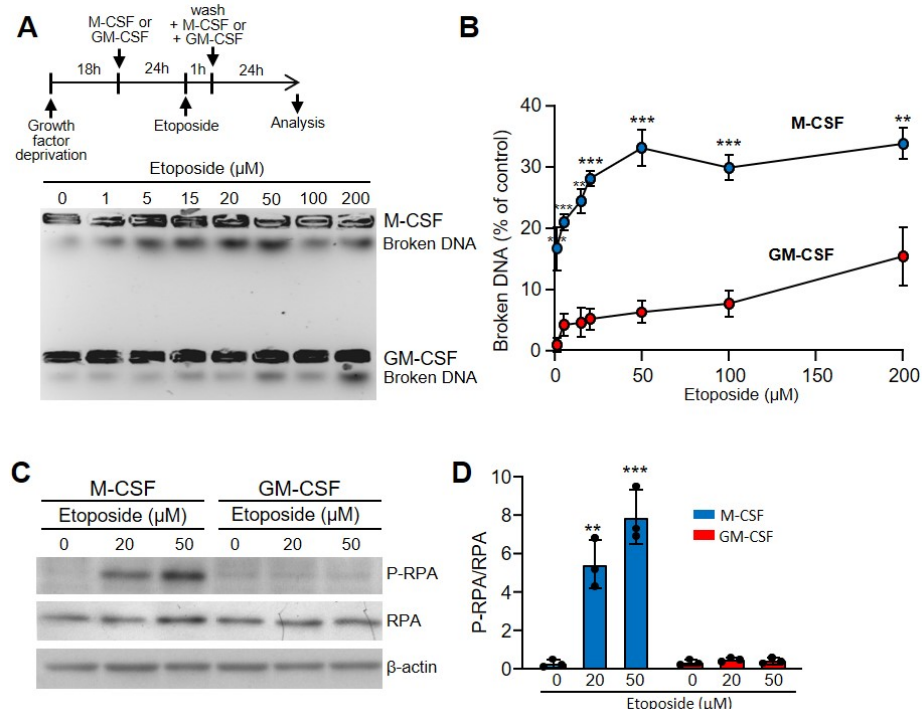
Figure 1. Etoposide induced more DSBs in macrophages incubated with M-CSF in relation to those incubated with GM-CSF. ( A ) The experimental design is shown at the top. Macrophages were obtained after 7 d of culture in the presence of M-CSF. Cells were deprived of M-CSF for 18 h and then incubated for 24 h with M-CSF or GM-CSF. Unless specified otherwise, the concentrations of growth factors used were 10 ng/mL. After that, etoposide was added for 1 h at the indicated concentrations, cells were washed and M-CSF or GM-CSF added again for 24 h before analysis. Representative results for DSBs determined using the FAR assay. ( B ) Quantification by densitometry of ( A ) (independent experiments, n = 3). ( C ) The experimental design is same as in A. Unless specified otherwise, the concentrations of etoposide and hydrogen peroxide used were 50 µ M and 250 µ M, respectively. SSBs were determined by immunoblotting of the phosphorylated RPA (RPA2, 32 kDa subunit), RPA (RPA1, 70 kDa subunit) and β -actin as controls. ( D ) P-RPA/RPA relation quantified by densitometry of C ( n = 3). Each experiment was performed in triplicate, and the results are shown as the mean ± SD. ** p < 0.01 and *** p < 0.001 in relation to the corresponding treatments with M-CSF or GM-CSF, when all the independent experiments had been compared. Data were analyzed using Student’s t -test, with the exception of ( D ), which was performed using ANOVA